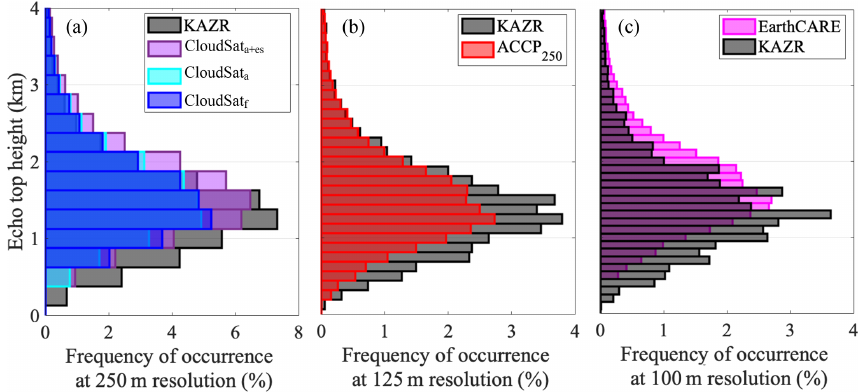
Figure 8. For 719 forward-simulated days, distribution of echo top height observed by the KAZR (grey) and estimated from the forward- simulated radar architectures. Results are estimated at various range sampling resolutions according to the capability of each spaceborne sensor configuration. All acronyms and colors are defined in Fig.